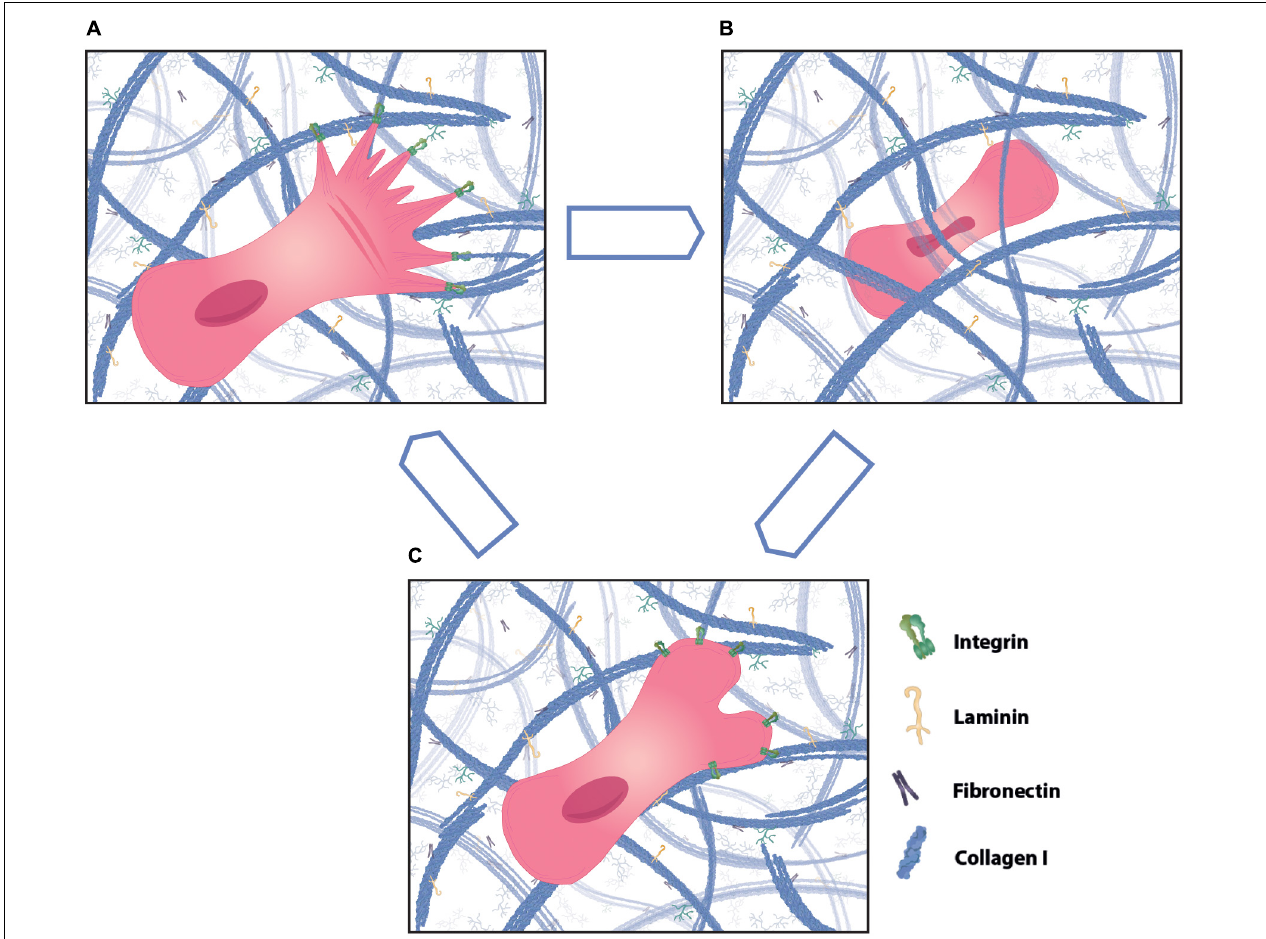
FIGURE 4 | Different modes of cell migration in three-dimensional (3D) matrix. Cells can migrate through 3D matrix using different ways of motility, such as mesenchymal, amoeboid and lobopodial migration. (A) Mesenchymal migration is characterized by high adhesions and cell protrusions at the leading edge that align along collagen fibers. Cells that mainly use mesenchymal migration leave behind a tunnel in the ECM that can be utilized by following cells as tracks. (B) In contrast, amoeboid cell migration is less dependent on matrix adhesions. Cells show strong cell body and nucleus deformation during migration through tight spaces and generally choose the path of least resistance. (C) Lobopodial migration shows features of mesenchymal and amoeboid migration and typically has bleb protrusions at the migration front. Cells using one form of migration can change to using another form dependent on the